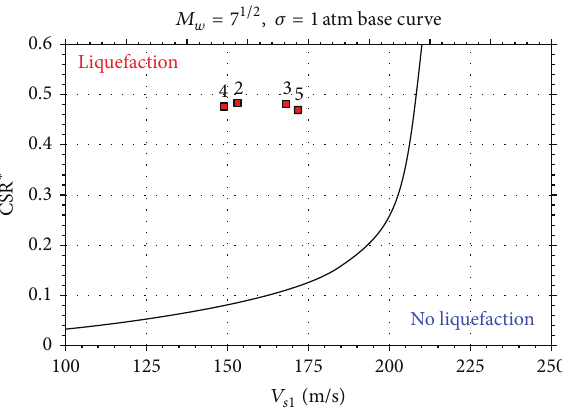
Figure 9: Borehole 23 was chosen to check and compare for liquefaction potential as a sample for shear wave